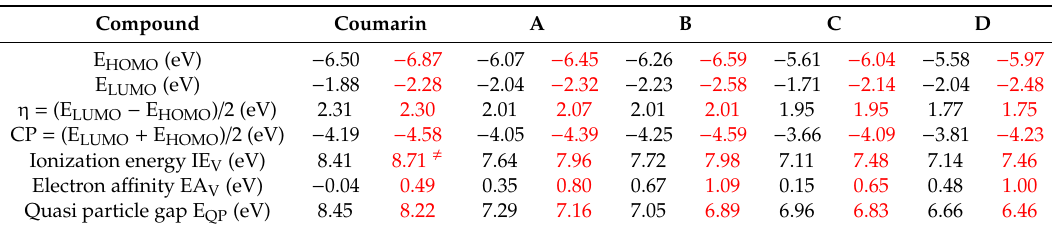
Table 2. Electronic properties of the Coumarin and derived compounds A , B , C and D , employing B3LYP XC in combination with basis set 6-31G*, and 6-311 + G*